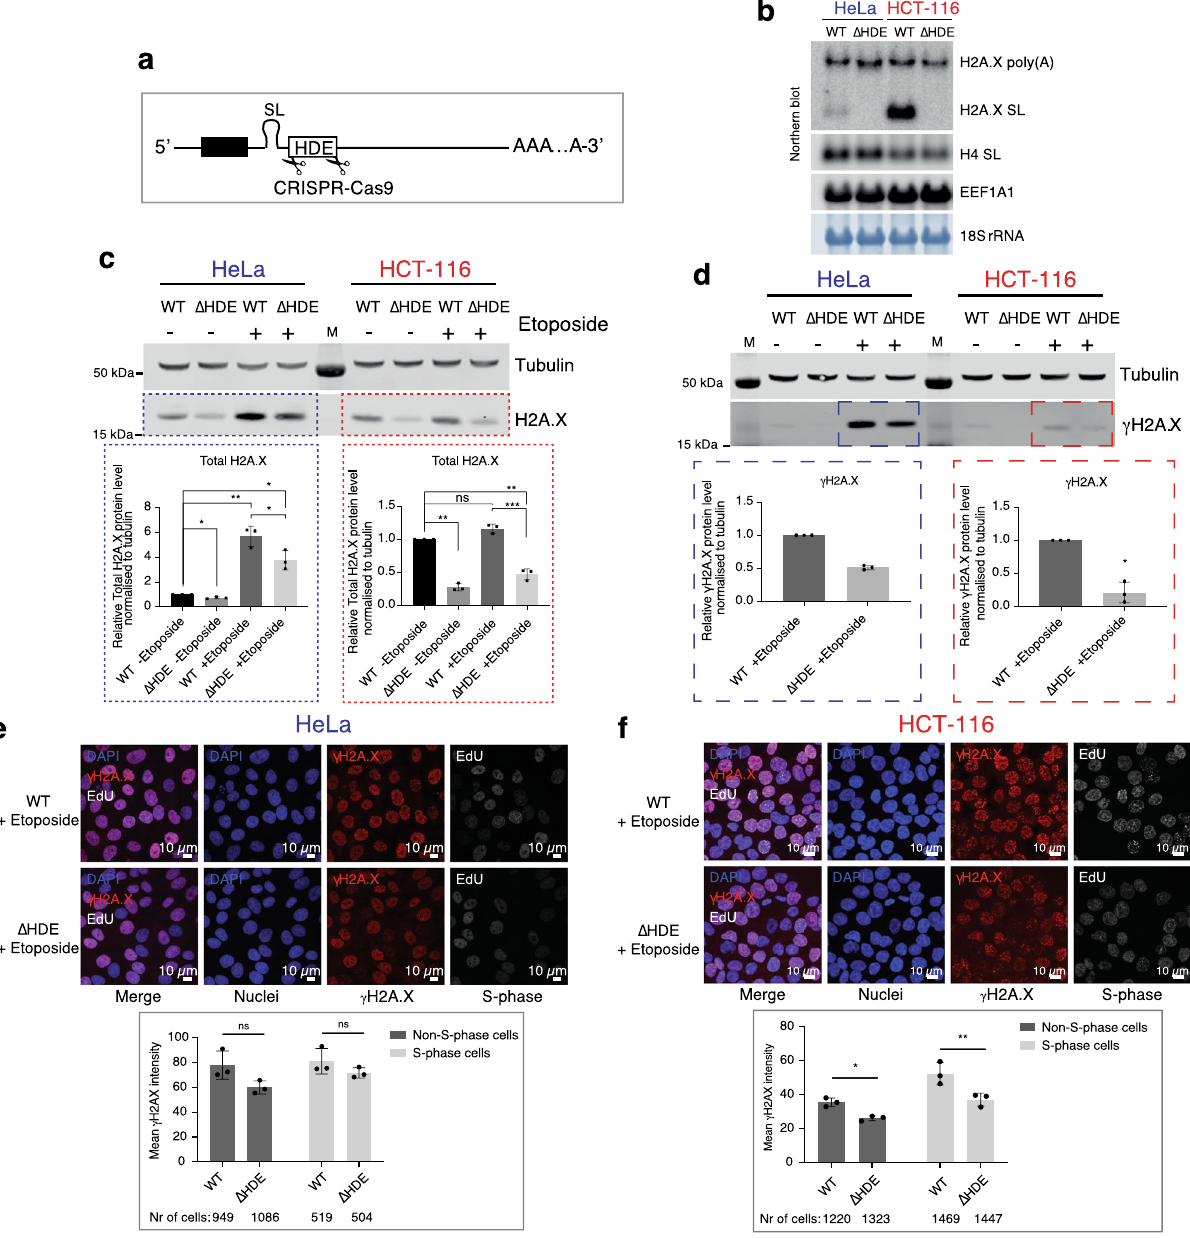
Fig. 7 Effect of H2A.X SL mRNA loss in control versus DNA damage conditions. a Schematic of CRISPR HDE deletion. Two guide RNAs fl anking HDE were used together with a ssDNA oligonucleotide template for homologous recombination. b H2A.X mRNA northern blot of total RNA from asynchronous WT (WT) and Δ HDE HeLa and HCT-116 cells. H4 SL: core H4 histone SL mRNA. EEF1A1 mRNA and 18S rRNA used as loading controls. c , d Western blots showing total H2A.X ( c ) and γ H2A.X ( d ) protein levels in WT and Δ HDE HeLa and HCT-116 cells, with or without etoposide treatment. Tubulin: loading control. M: protein size marker. Blue (HeLa) and red (HCT-116) dotted lines highlight bands used for quanti fi cation, shown in graphs below. Quanti fi cations represent total or γ H2A.X levels normalised to tubulin and relative to the WT. Mean ± SD presented for n = 3 independent experiments. Paired Student ’ s t -test, ns: not signi fi cant P -value >0.05, * P -value ≤ 0.05, ** P -value ≤ 0.01, *** P -value ≤ 0.001. e IF images of WT and Δ HDE HeLa cells treated with etoposide, labelled with EdU (white). Quanti fi cation of nuclear γ H2A.X signal in etoposide-treated HeLa cells, comparing the γ H2A.X intensity between WT and Δ HDE cells in non-S-phase or S-phase cells. 10 images of each sample were analysed for a total of three independent experiments. Mean ± SD presented for n = 3 independent experiments. Two-way ANOVA with Sidak ’ s multiple comparisons test. ns: not signi fi cant P -value >0.05, * P -value ≤ 0.05, ** P -value ≤ 0.01. f Same as in e but for HCT-116